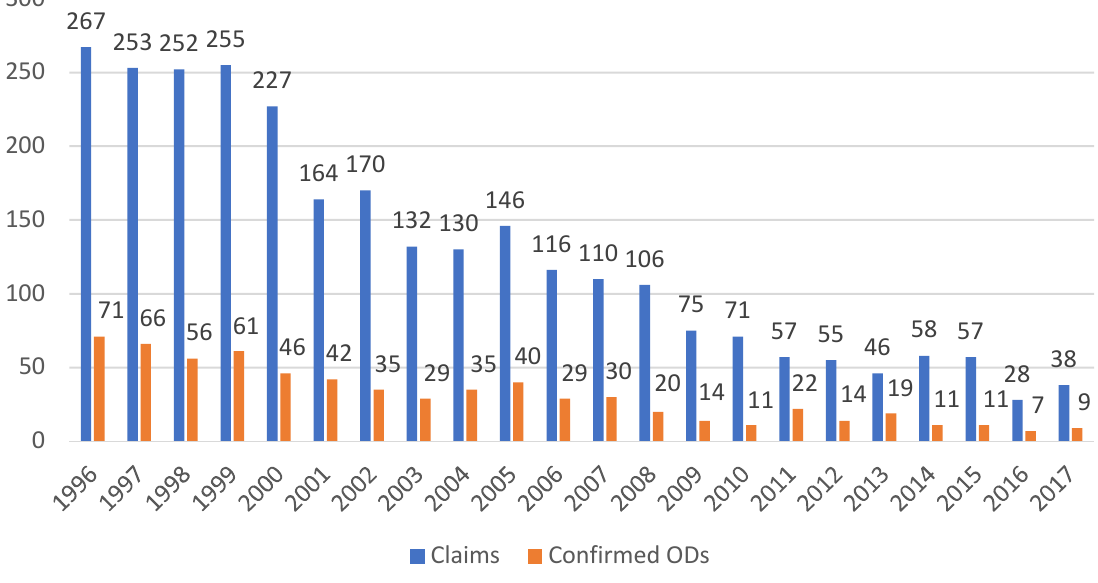
Figure 1. Hepatitis B: Claims and confirmed ODs from 1996 to 2017. Average confirmation rate for hepatitis B virus (HBV): 24.3% (total number of claims: 2817; total number of confirmed ODs: 685). Table 2. Hepatitis B and C claims and confirmed occupational diseases (ODs) per 100.000 full-time workers from 1996 to